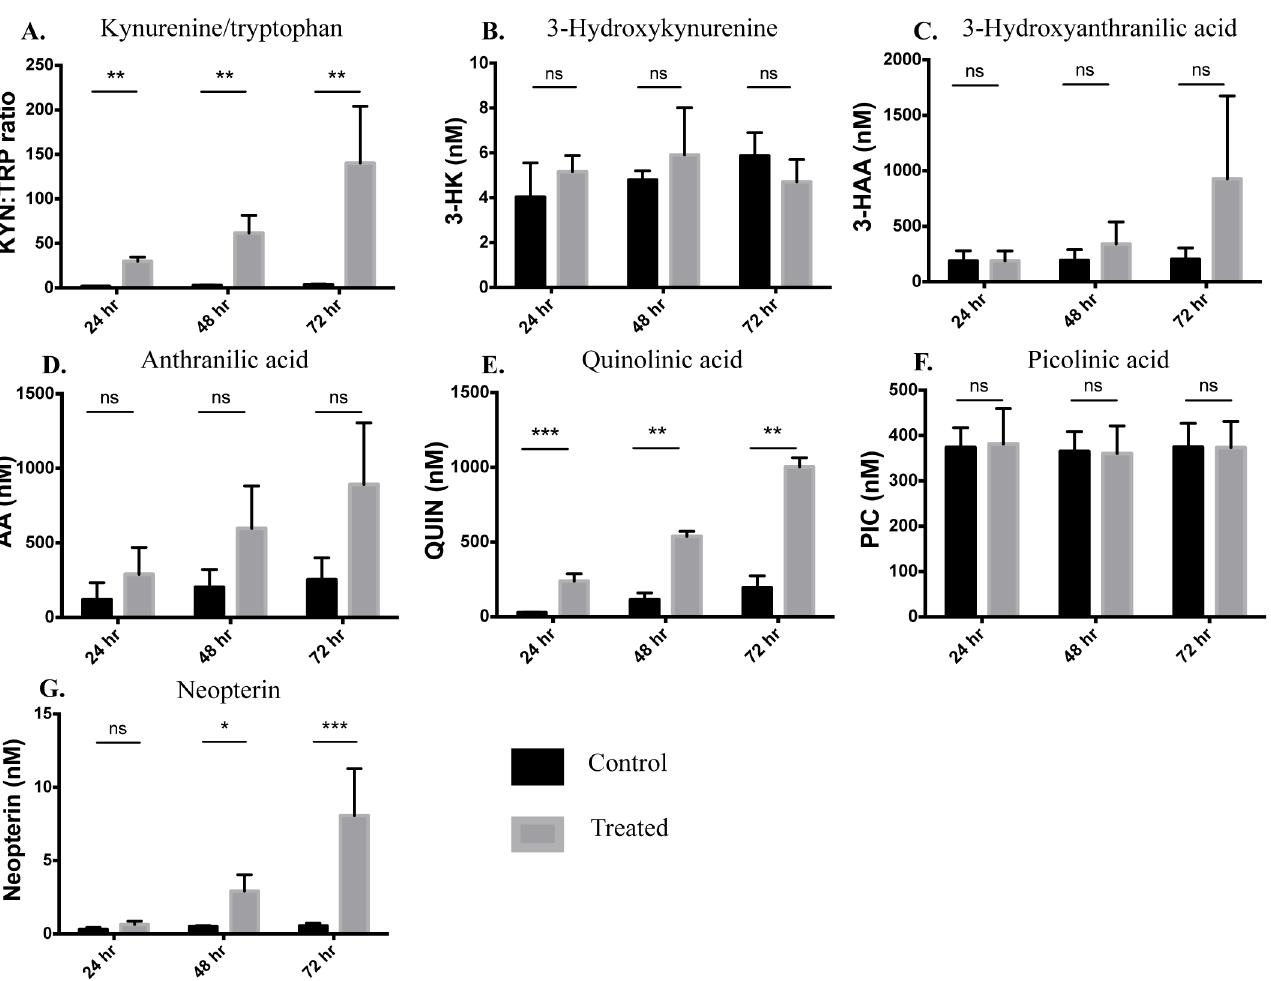
Fig 4. Concentrations of KP metabolites in the supernatants of IFN- γ activated PBMCs. Levels of KP metabolites: tryptophan (TRP) and kynurenine (KYN)-shown as TRP:KYN ratio ( A ); 3-hydroxykynurenine (3-HK) ( B ); 3-hydroxyanthranillic acid (3-HAA) ( C ); anthranilic acid (AA) ( D ); quinolinic acid (QUIN) ( E ); picolinic acid (PIC) ( F ) and the pro-inflammatory marker: neopterin ( G ) were measured by UHPLC or GC-MS (QUIN and PIC only) in the supernatants of PBMCs untreated (control-black bars) or treated with IFN- γ (500 IU/mL-grey bars) at 24, 48 and 72 hours of culture. Values represent the mean ± SEM of 4 independent biological repeats (ns = no significant difference, * p < 0.05, ** p < 0.01, ** p <